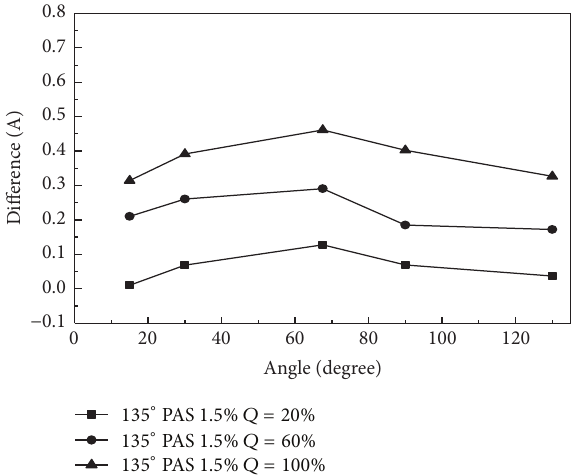
Figure 24: The PAS 1.5% angle of curved tube: difference diagram of various flows in 135 ∘ curved tube.